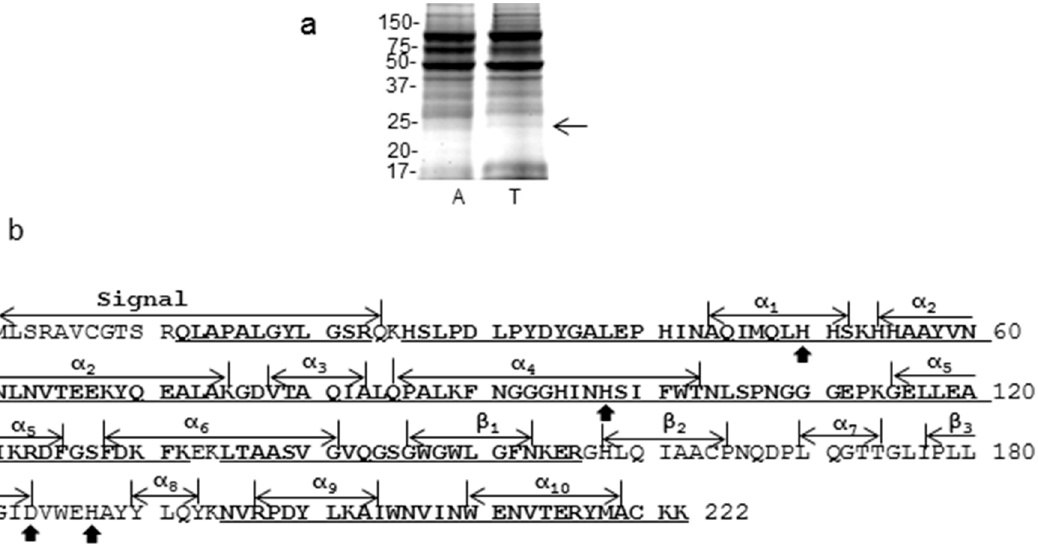
Figure 2. LC-MS/MS coverage of MNSOD. ( a ) Whole cell lysates from kidney tissues were separated by SDS-PAGE and stained by Coomassie Blue (arrow indicated MNSOD). The gel image is the representative of 4 pairs of tumor and adjacent tissues used for PTMs analysis. A: adjacent; T: tumor; ( b ) CID-based sequence coverage of MNSOD. After Coomassie Blue staining, the 22 kDa protein bands corresponding to MNSOD were cut from the gel and digested, and peptides were analyzed by LC-MS/MS on LTQ-Orbitrap mass spectrometer (MS). The underlined amino acids (bold letters) were identified by Proteome Discoverer 1.4 (MASCOT and SEQUEST), which covered 76.13% sequence of MNSOD. Signal: the signal peptide; α : the α -helices; β : the β -sheets, subscript numbers represent original numbers; solid arrows: metal (Mn 2+ ) binding sites. Table 1. Frequency of +16 modification events of MNSOD at different amino acid residues *.